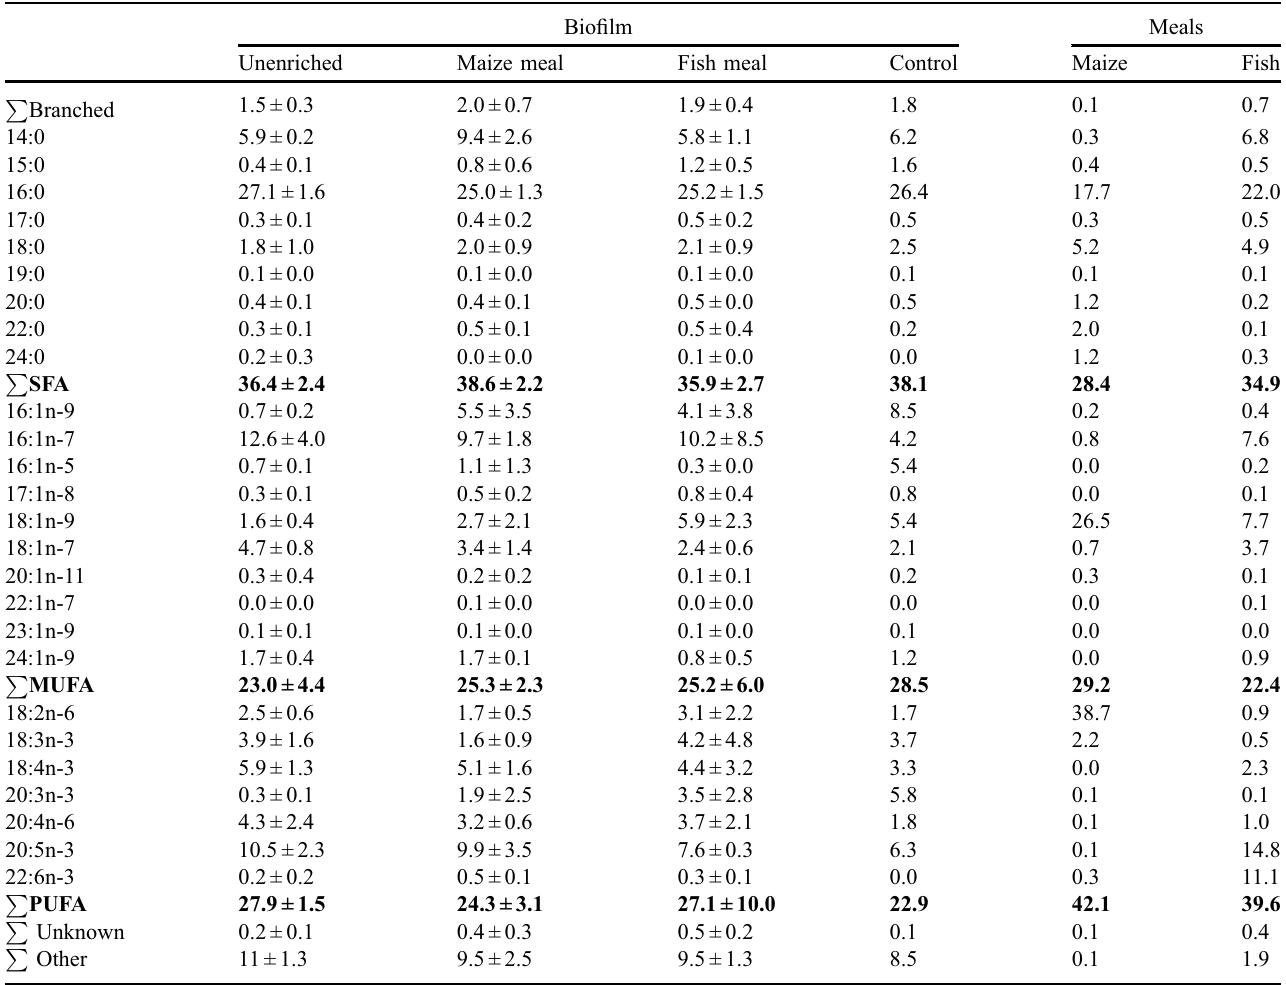
Table 2. Fatty acid composition (mass % of total FA, mean ± S.D.) of bio fi lm (after 7 months) ( n =3), maize and fi sh meals ( n = 2). SFA: saturated FA; MUFA: monounsaturated FA; PUFA: polyunsaturated FA; Branched: FA [15iso þ 15anteiso þ 16iso þ 17iso þ 17anteiso]. Bio fi lm Meals Unenriched Maize meal Fish meal Control Maize Fish P